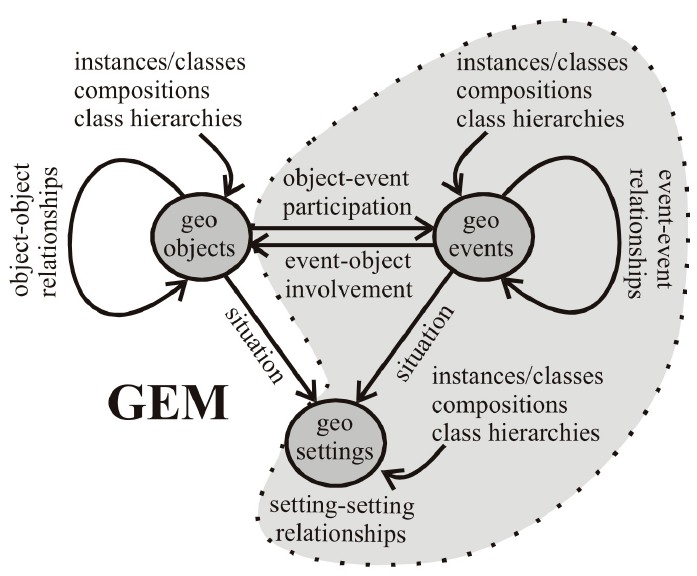
Figure 8. The geospatial event model (GEM) model: objects, events, and their interaction. At the relationship level, participation and involvement are used to indicate that objects participate in events and events involve objects . Worboys and Hornsby also specify event-object relationships ( creation , sustaining in being , reinforcement/degradation , destruction , splitting/merger ) and event-event relationships ( initiation , perpetuation/facilitation , hin- drance/blocking , termination ). One of the characteristics of GEM is to be able to describe combination relationships as well as temporal relationships between elements. Another specificity is its capacity to describe relationships between events through event-event rela- tionships. Since it allows for event-object relationships to be stored, and since it explicitly represents events, GEM belongs to both functionality levels 2 and